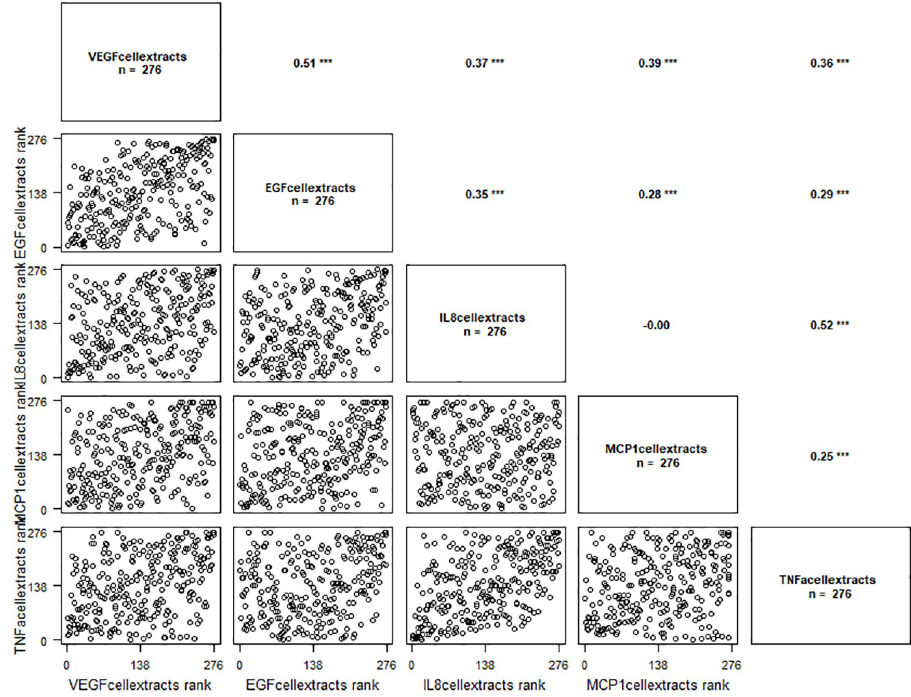
Fig 1. Correlation graph between VEGF protein levels (VEGF cellular extracts) and EGF, IL-8, MCP1 and TNF- α cellular extracts levels. ‘ ��� ’ p � 0.001.